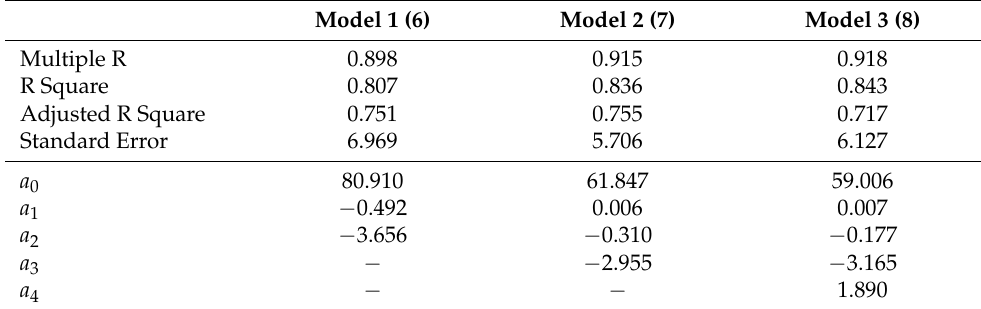
Table 3. Regression statistics and parameters of static models.